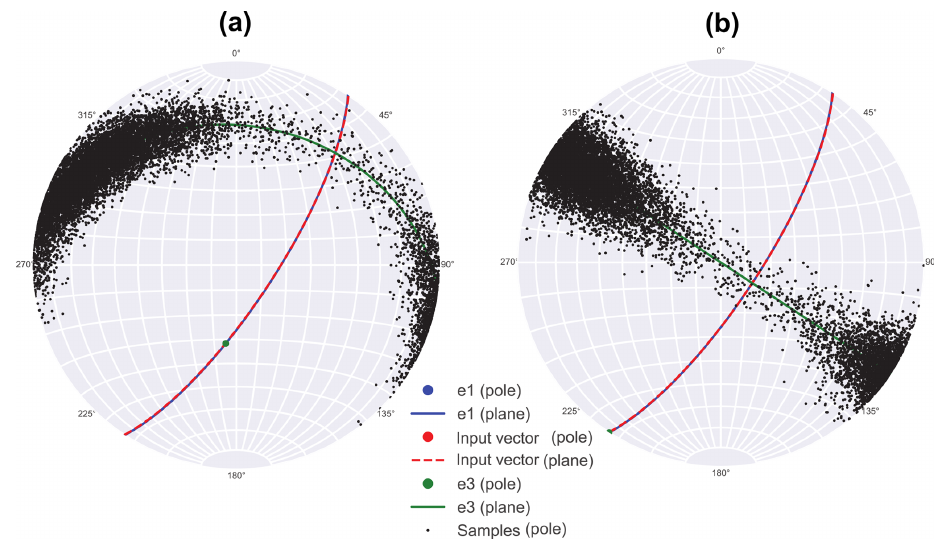
Figure 3. (a) Random e 3 orientation of anisotropic Bingham distribution resulting from simulation and (b) rotated distribution with properly aligned e 3